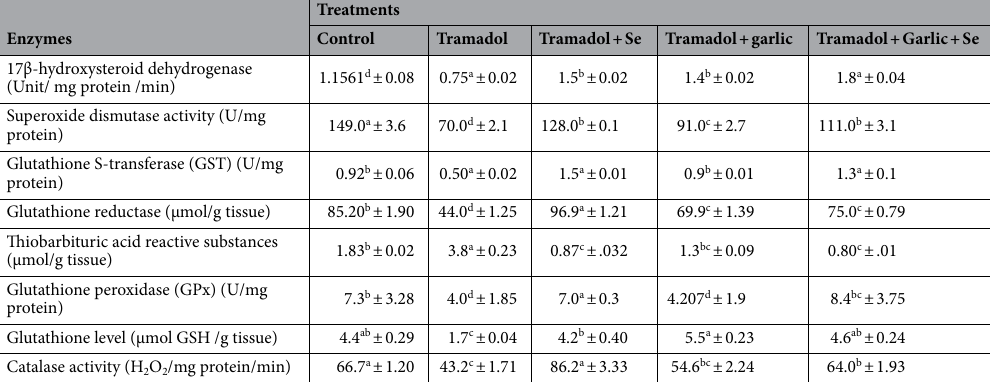
Table 2. Changes in the activity of 17β-hydroxysteroid dehydrogenase and antioxidant enzymes in testes of rabbits after pretreatment with selenium, garlic, or their combination for 2 h prior to tramadol administration. All values were presented as the mean and standard error of five rabbits. abc Means with different superscript letters were stastiscially significants. abc Means with the same superscript letter were not stastiscially significant. The level of significance for the differences between means was set at P <